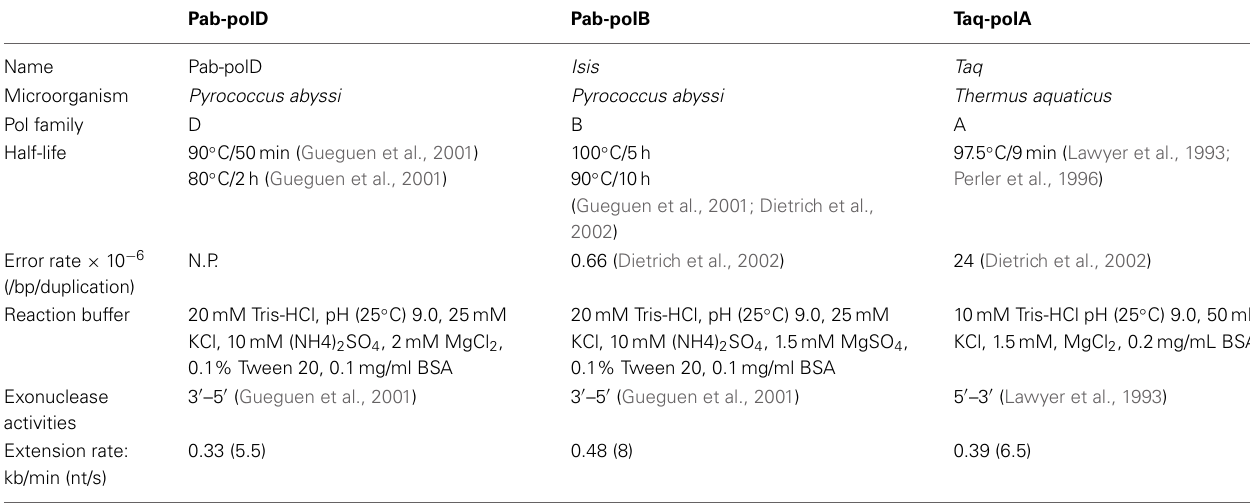
Table 2 | Properties of experimental thermophilic DNA polymerases. Pab-polD Pab-polB